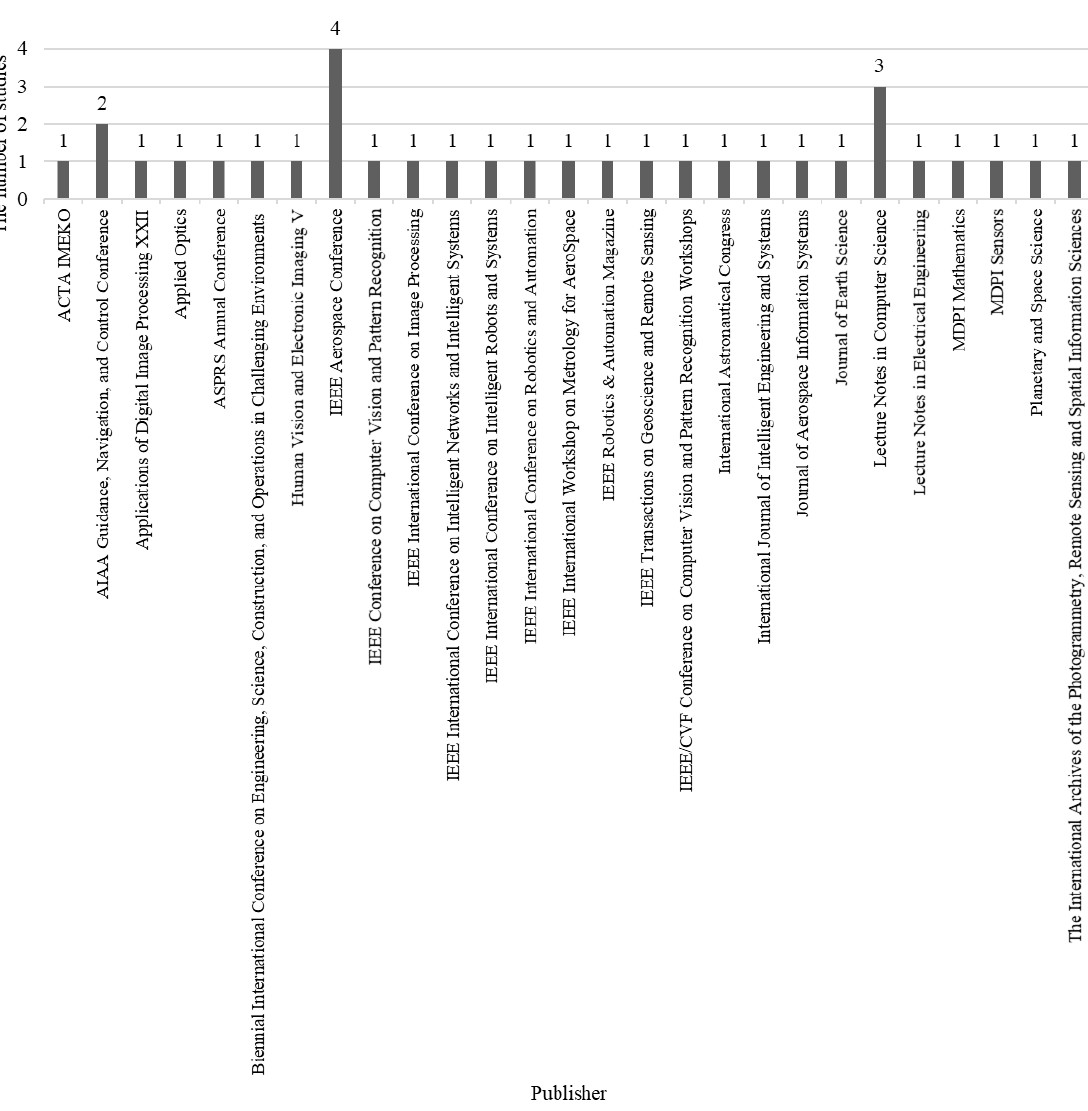
Figure 4. The distribution by publisher in the Included Study .